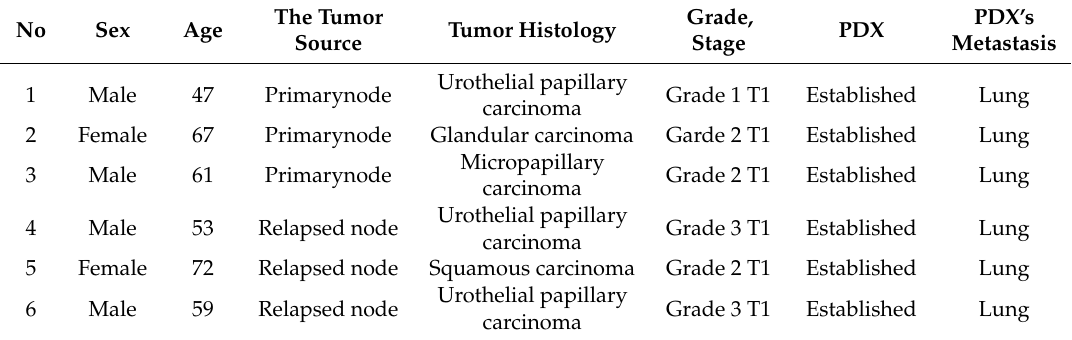
Table 1. The list of patients from whom the tumor tissues have been taken for patient-derived xenografts (PDX)